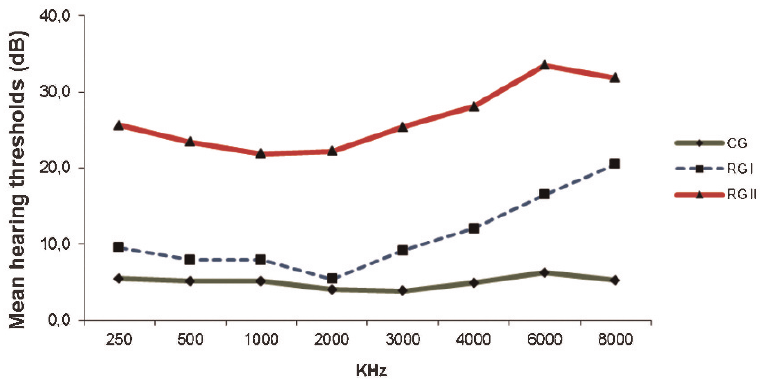
Figure 1 - Mean hearing thresholds for the pure-tone audiometry frequencies in both the right and the left ears for the Control Group, Research Group I, and Research Group